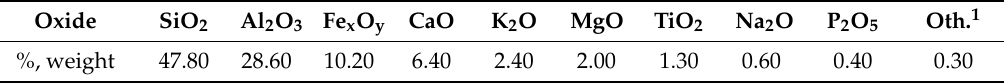
Table 1. Indigenous coal ash oxide chemical